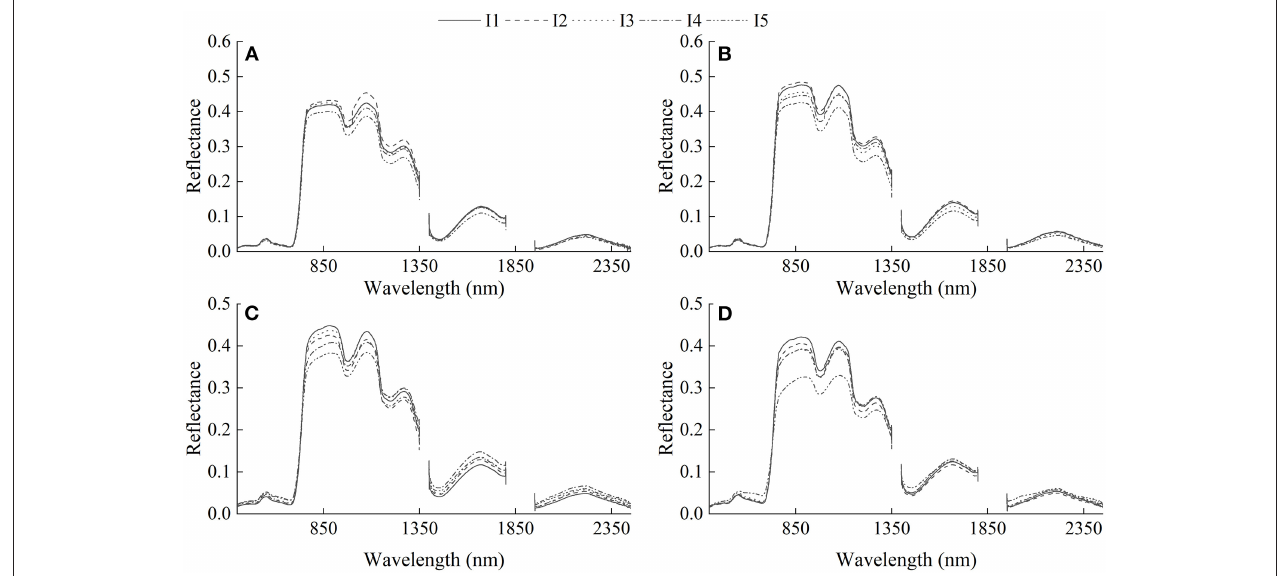
FIGURE 3 | Changes of canopy reflectance with varied irrigation regimes. (A) Jointing stage, (B) booting stage, (C) flowering stage, and (D) filling stage. I 1 represents four irrigations at jointing, booting, flowering, and filling stage. I 2 represents three irrigations at jointing, booting, and filling stage. I 3 represents two irrigations at jointing and flowering stage. I 4 represents two irrigations at jointing and filling stage. I 5 represents the treatment without irrigation.